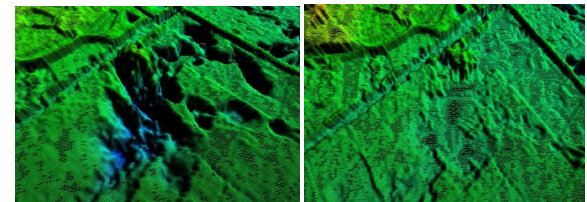
Fig.2 TIN constructed by ground data (left) and surface fitting(right)